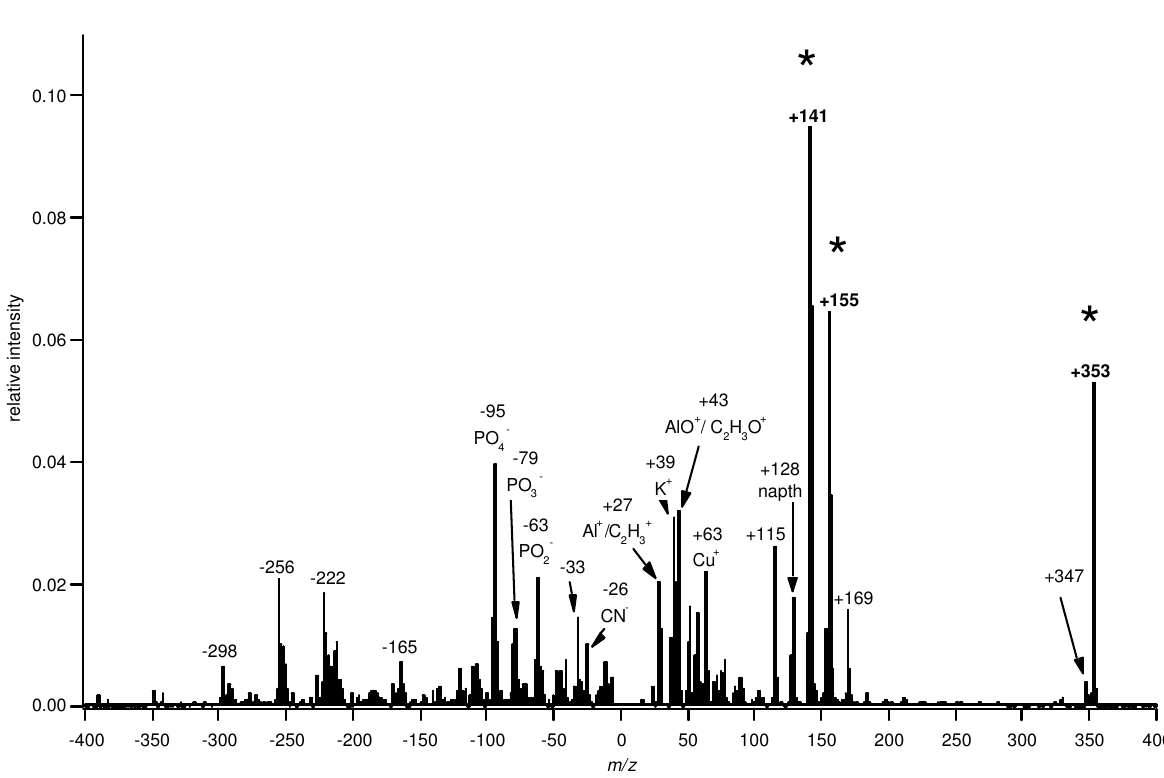
Figure 7. Average mass spectrum from a lubricating oil standard diluted in methyl ethyl ketone and atomized directly into the ATOFMS. Specific peaks that are conserved through combustion and used as lubricating oil tracers are identified with a